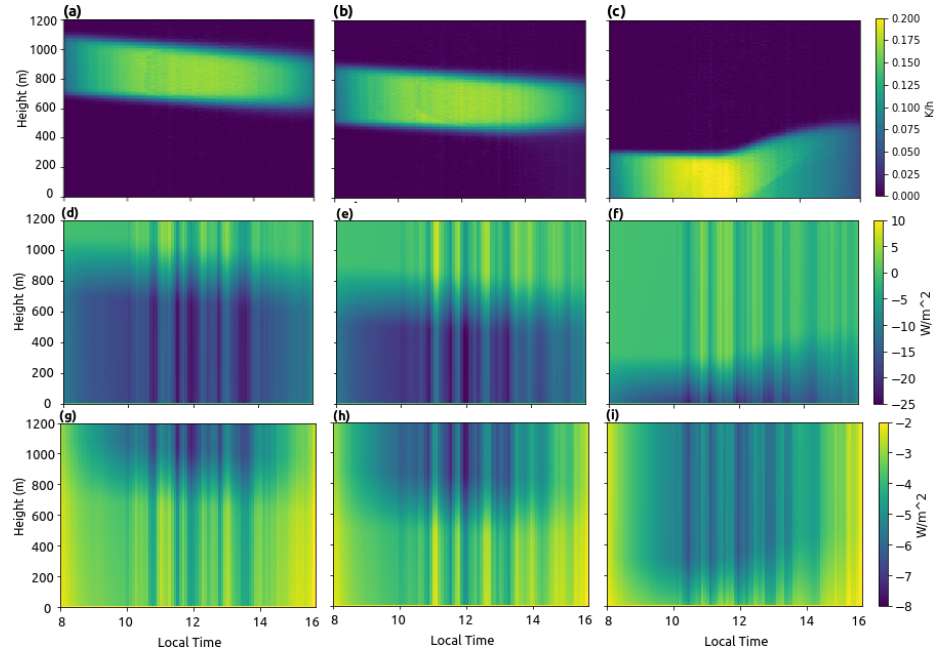
Figure 5. SW heating rate (a–c) , loss in downwelling (d–f) and upwelling (g–i) SW radiation due to BC inclusion in the aerosol layer. All plots are normalised against no BC simulations (BC in the aerosol layer – no BC in the aerosol layer) for Aero_load_BC700 (a, d, g) ,